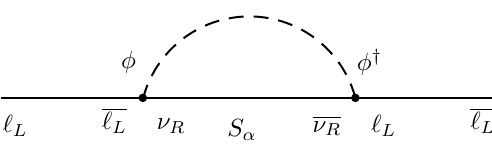
Figure 2 . One-loop self-energy diagram for the light (cid:23) L neutrinos with an intermediate charge- conserving (cid:23) R propagator S . The (cid:12)elds at the vertices are shown explicitly for comparison with the Lagrangian